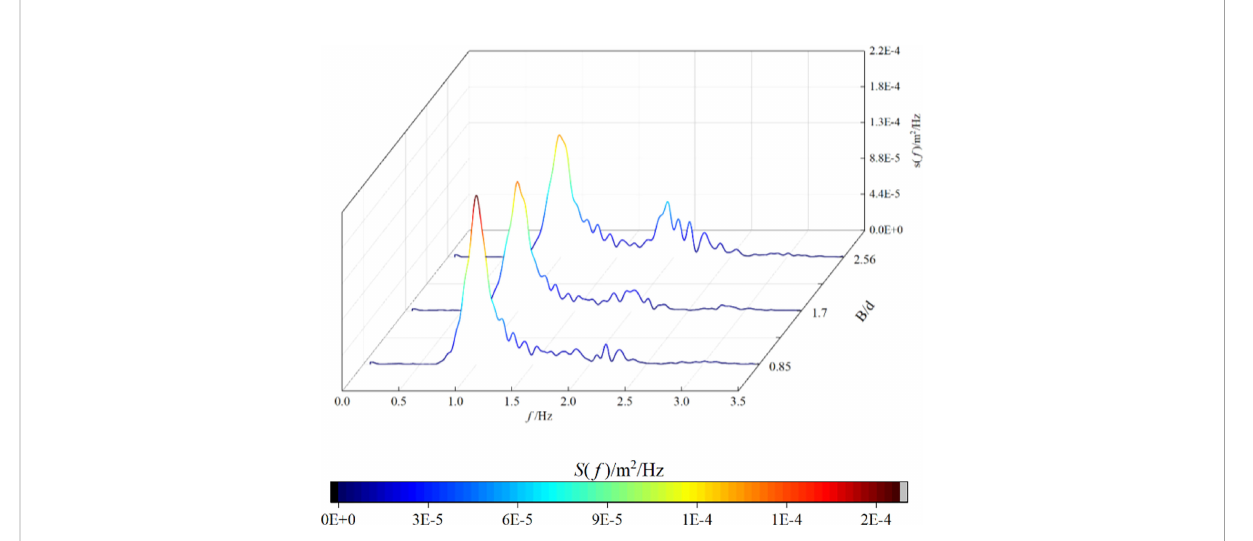
FIGURE 9 Comparison of the energy spectrum distribution under different top widths ( D = 0.27 m, H i = 0.043 m, T = 1 s, x = 1.5